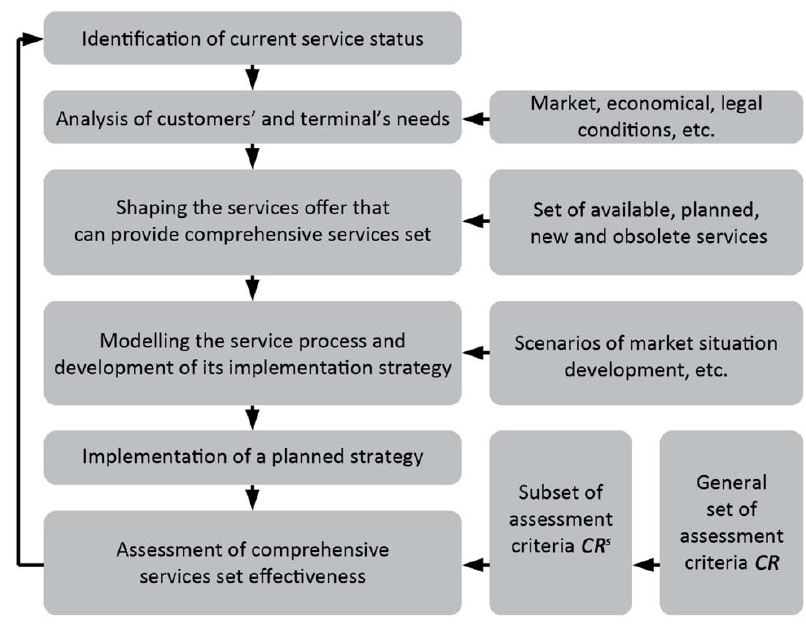
Figure 4. Procedure for formulation of a set of comprehensive services at transshipment terminal.